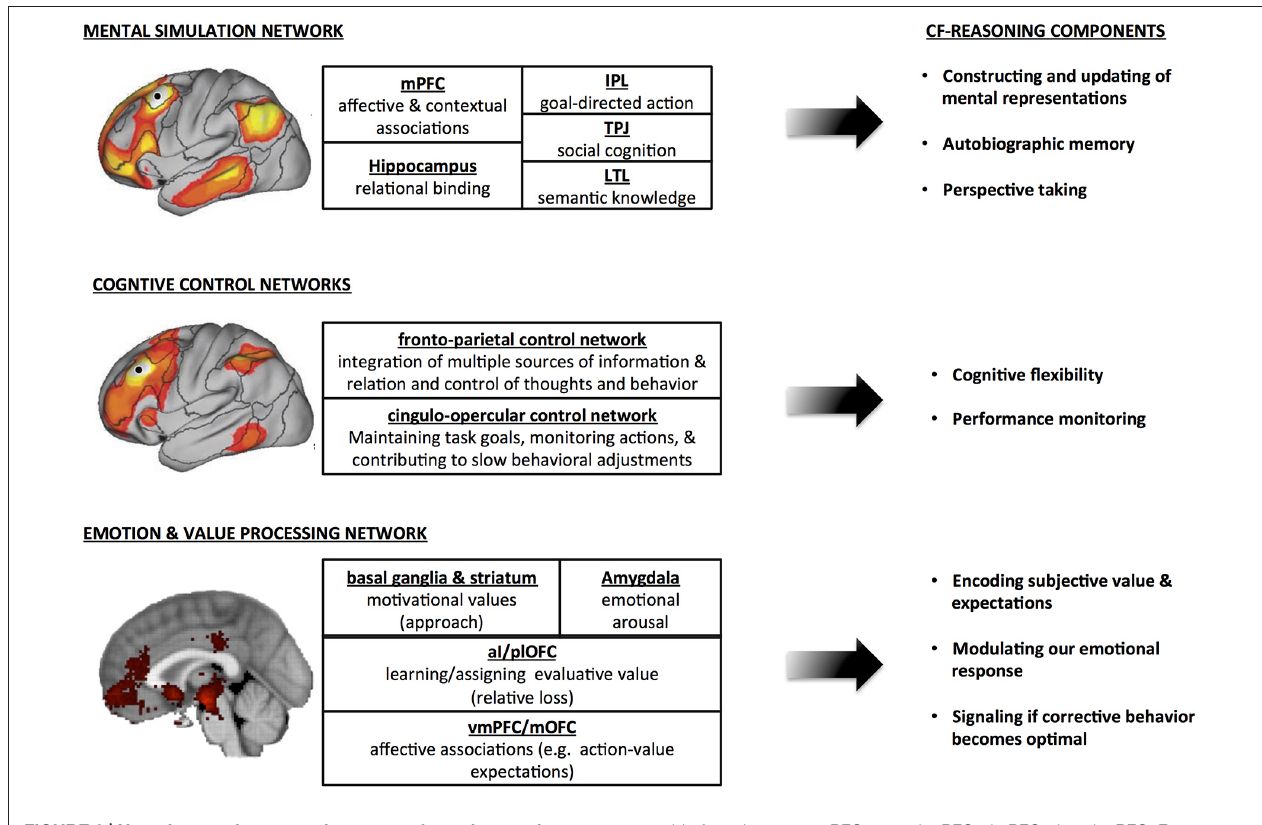
FIGURE 2 | Neural networks supporting counterfactual reasoning: a schematic overview. CF, counterfactual; mPFC, medial prefrontal cortex; IPL, inferior partietal lobe; TPJ, temporo-parietal junction; LTL, lateral temporal lobe; aI, anterior insula; plOFC, posterior